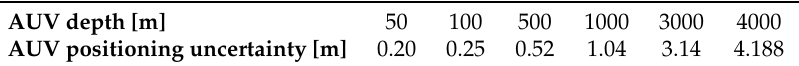
Table 10. Expected AUV positioning accuracies of HiPAP measurement (1 σ ).